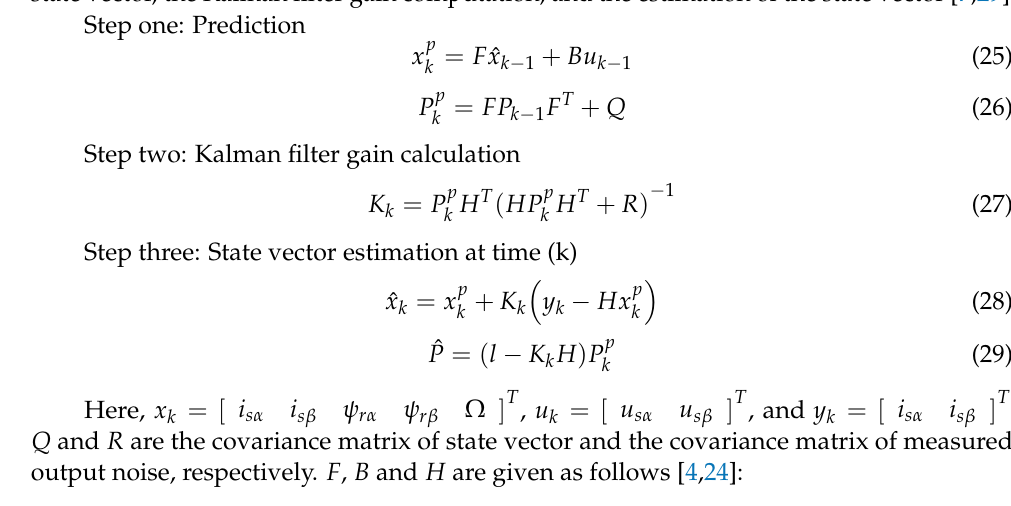
Figure 3. Velocity responses of the induction machine using BSC and IBS-DISMC for a stator winding resistance change of +25%. Table 1. The parameters of the IM machine.